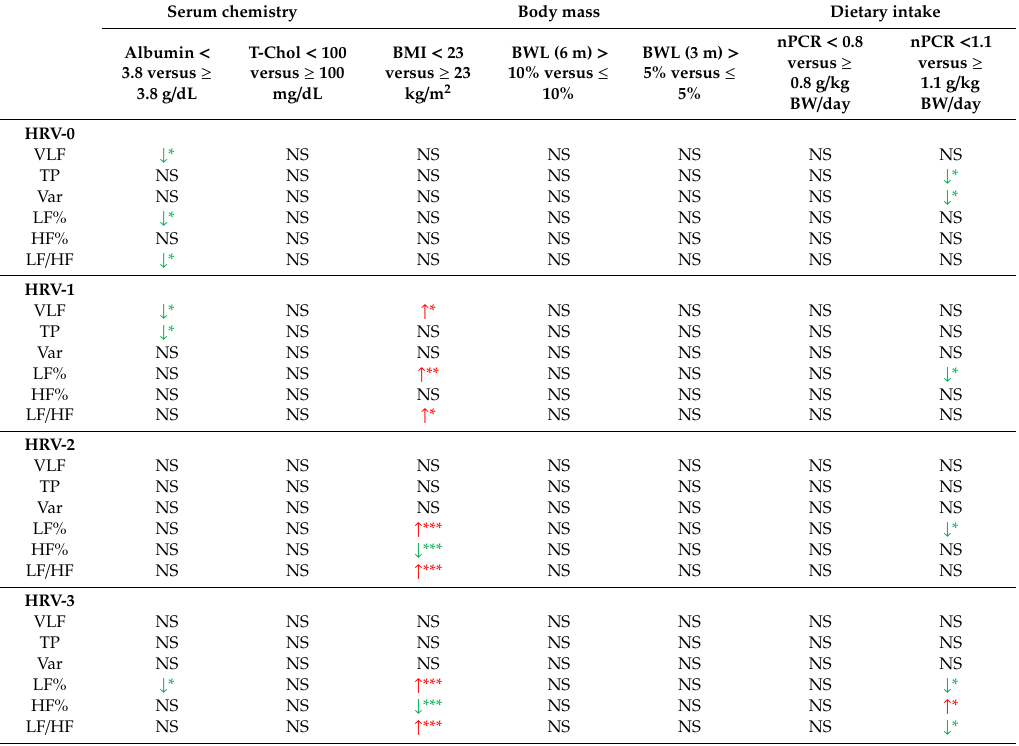
Table 2. Comparisons of the values of heart rate variability indices between the two groups categorized by nutritional